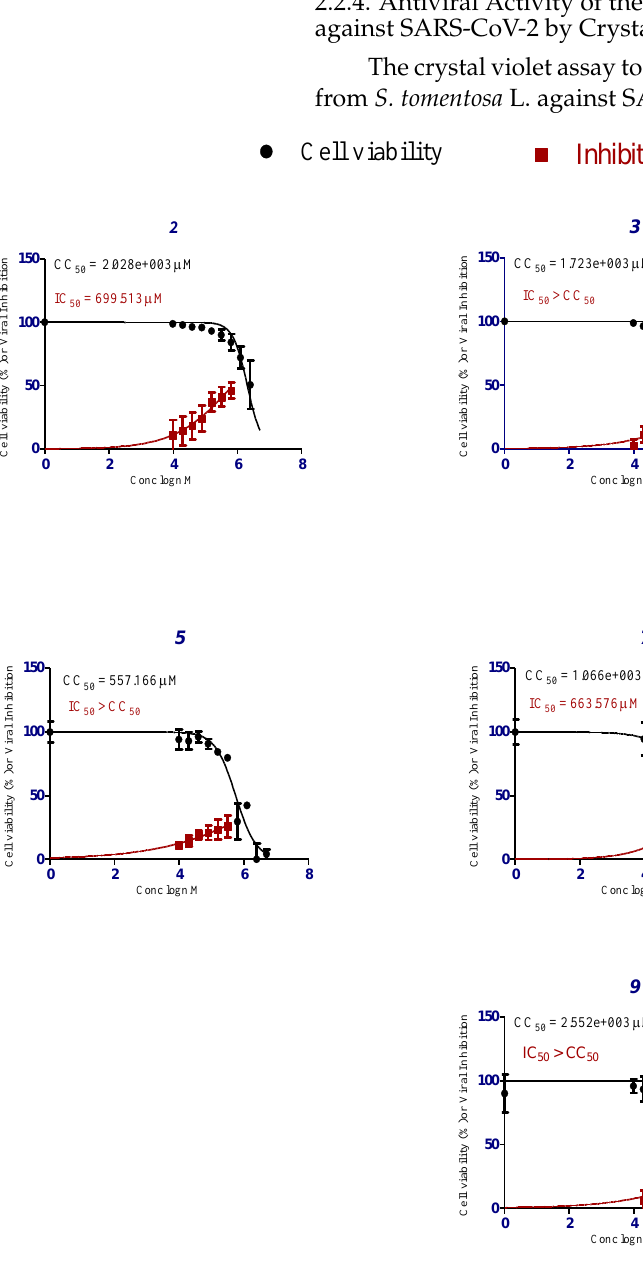
Figure 4. CC 50 and IC 50 of the isolated and identified compounds from S. tomentosa against SARS- CoV-2. 5,8-Dimethoxypsoralen ( 2 ), formononetin ( 3 ), genistein 4’-methyl ether ( 4 ), 4’,5-dihydroxy- 7-methoxygenistein ( 5 ), 5,7,4’-trihydroxy-3,6-dimethoxy flavone ( 7 ), 6-methoxy-7- O - β -D-glucoside apigenin ( 8 ), and daucosterol ( 9 ).